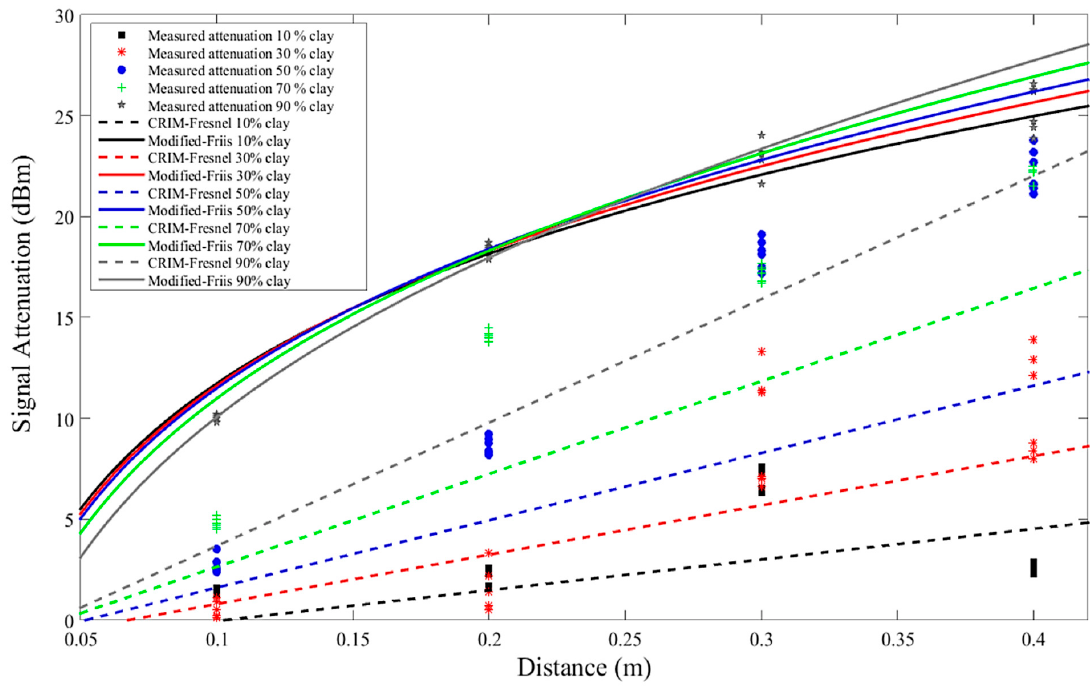
Figure 5. E ff ect of clay content on attenuation of signal and comparison of Modified-Friis Figure 5. Effect of clay content on attenuation of signal and comparison of Modified-Friis and CRIM- and CRIM-Fresnel. Fresnel.